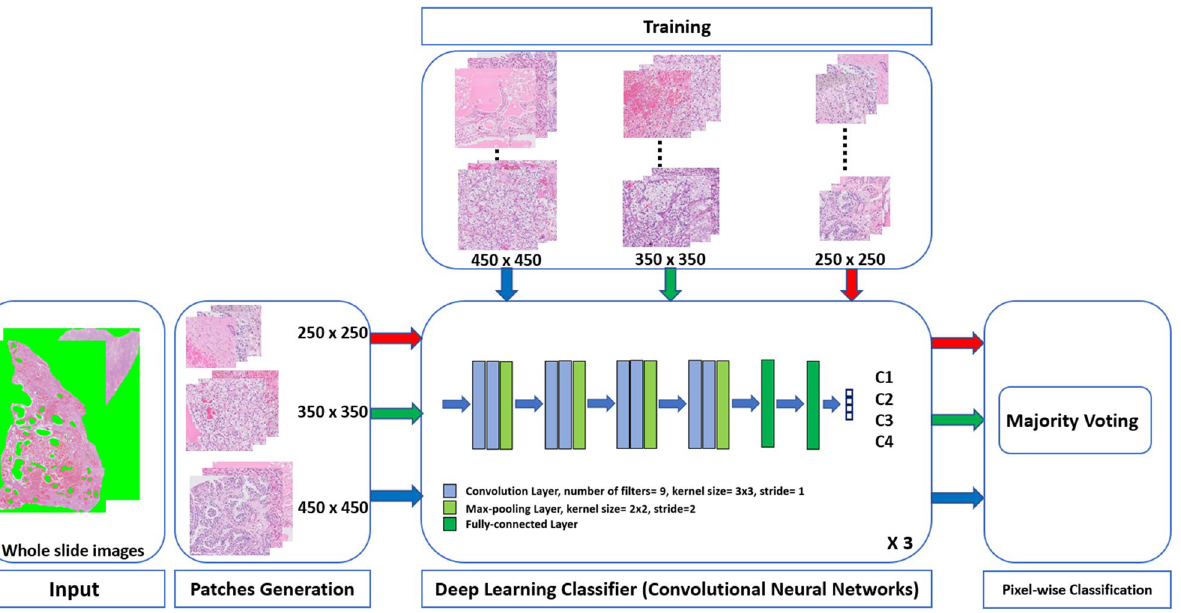
Figure 1. Schematic illustration of the proposed computer aided diagnostic system for automated classification of kidney